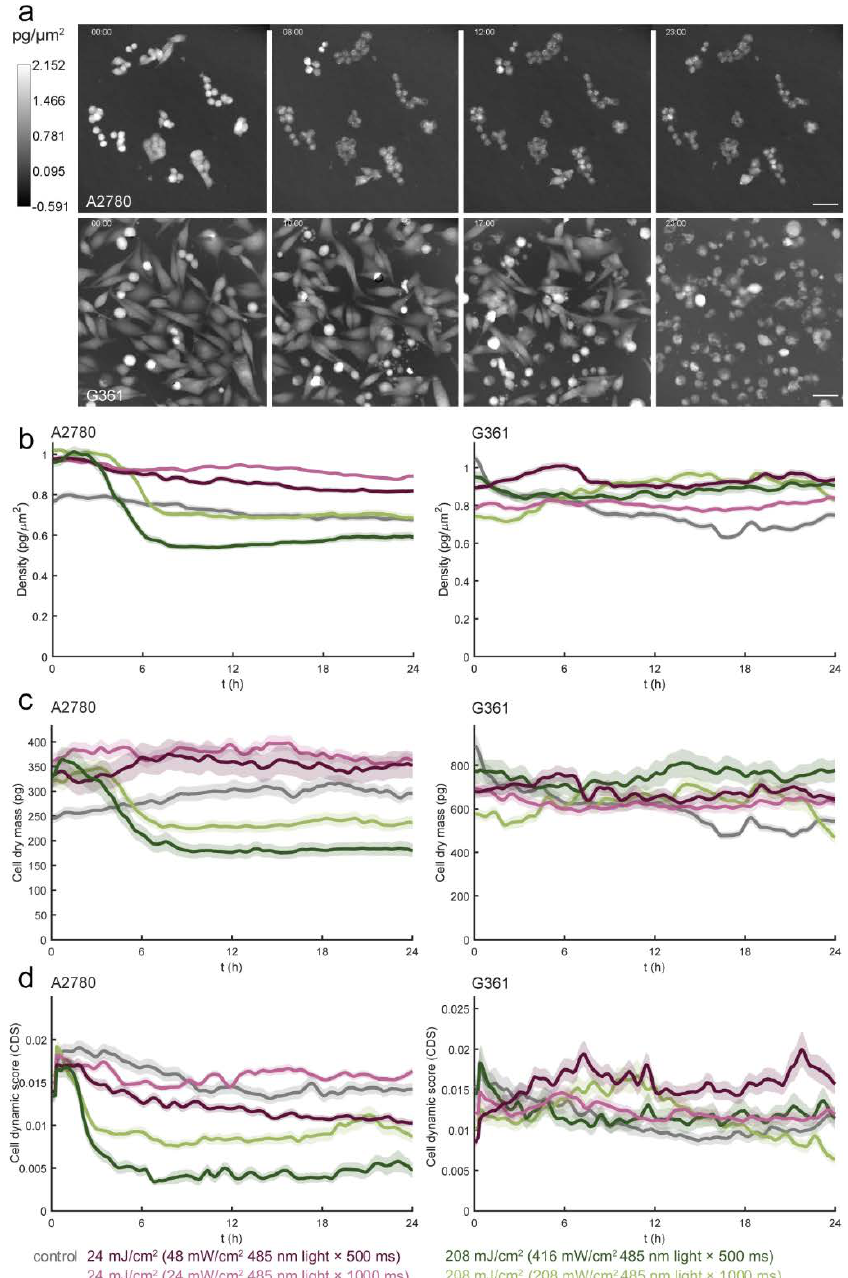
Figure 6. Quantitative phase-related parameters of dying A2780 and G361 cells. ( a ) Example of quantitative phase images for A2780 and G361 cells in different time-points under blue light dose 208 mJ / cm 2 × 1000 ms. Scale bar = 50 µ m ( b ) Real-time changes in cell density of A2780 and G361 cells during 24 h of the experiment. ( c ) Real-time changes in cell dry mass of A2780 and G361 cells during 24 h of the experiment. ( d ) Real-time changes in Cell Dynamic Score (CDS) of A2780 and G361 cells during 24 h of the experiment. CDS shows the average intensity change of cell pixels.